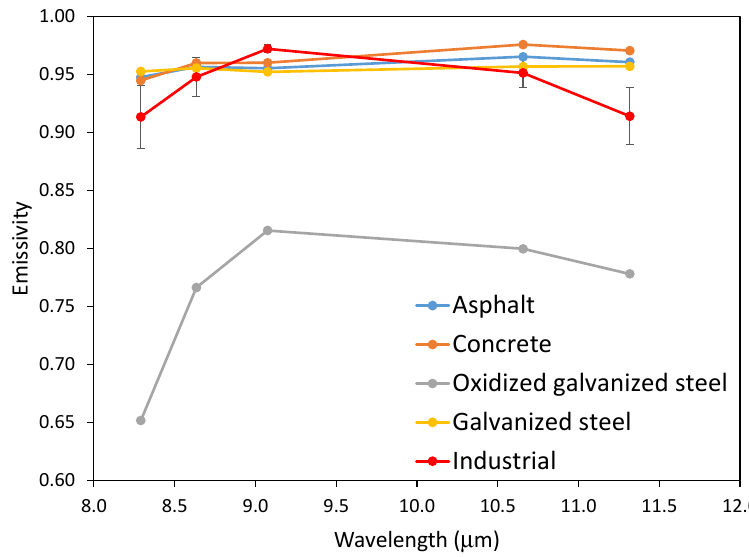
Figure 13. Mean emissivity of industrial construction materials retrieved from the ASTER Spectral Library and integrated for the five thermal ASTER bands.